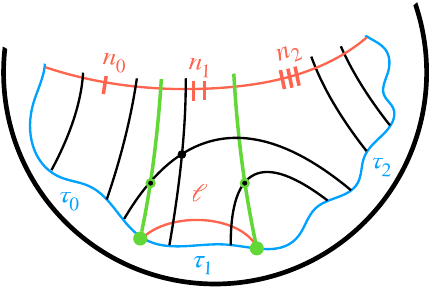
Figure 12 . The bulk Hilbert space with 2 particles in the interior in the chord picture. We can cut the chord diagram along in the Euclidean past ‘ . This is an “inital state” in the Euclidean past with n 0 = 0 , n 1 = ‘/λ, and n 2 = 0 . The n 1 wavefunction can be obtained by summing chord diagrams with no particles, as in section